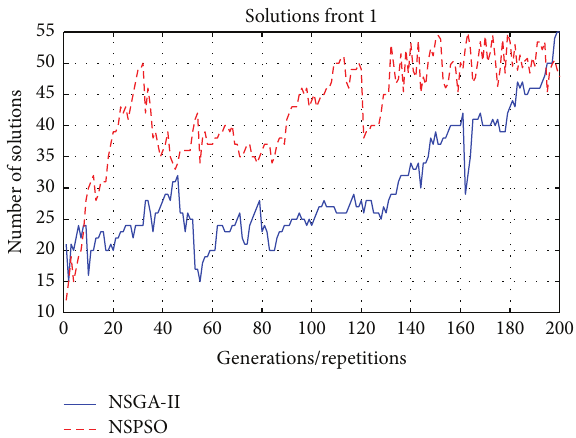
Figure5: Numberof solutionsobtained with theNSGAand NSPSO approaches.